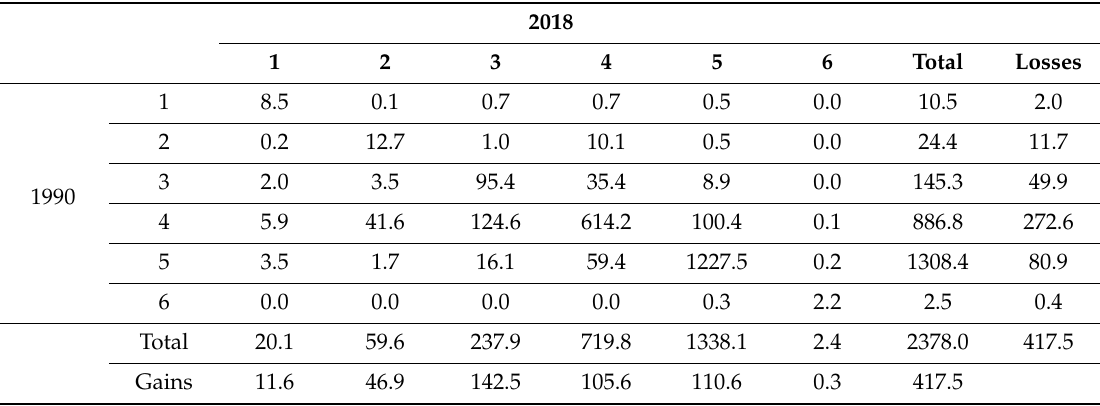
Table 5. Hue of change in spatial surface (km 2